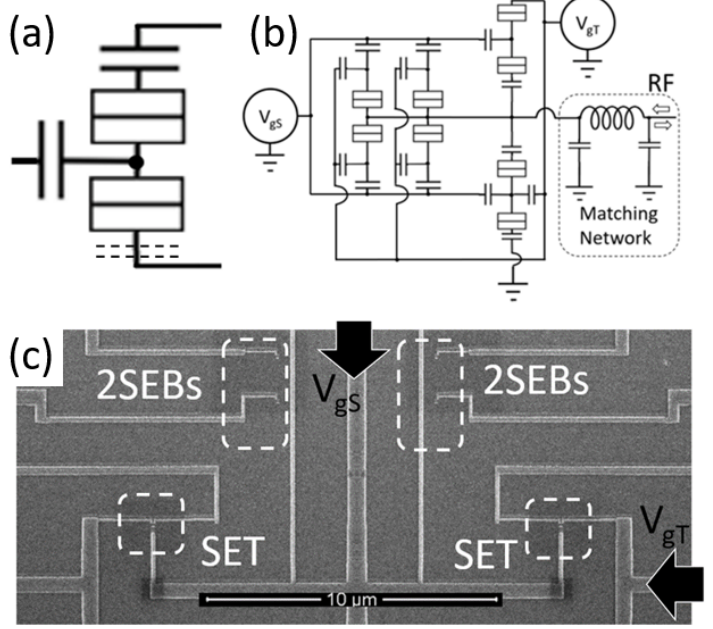
Figure 17. ( a ) Simplified circuit diagram of the DC decoupled-SET (DCD SET). Either one or both junctions are isolated with one or two non-leaky capacitors. ( b ) Circuit diagram of the experiment: two SETs and four SEBs are connected together to a single MN, with the SETs in counter-parallel configuration, and SEBs in parallel configuration. The lower SET in the diagram is a ”DC-decoupled.” ( c ) The electron micrograph of the structure used in the experiment. Four SEBs are clearly visible near V gs electrode The SET on the left is fully floating; the SET on the right is source-coupled to the V gT source (=AC ground).